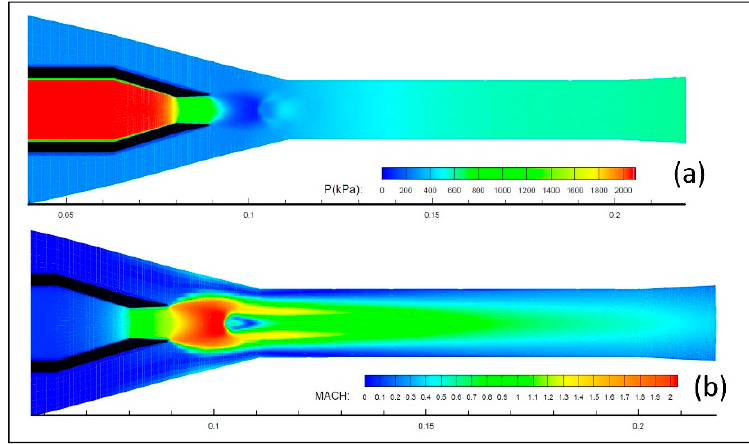
Figure 19. Typical internal ejector flow structure: (a) isobars; (b) Mach contours [213].